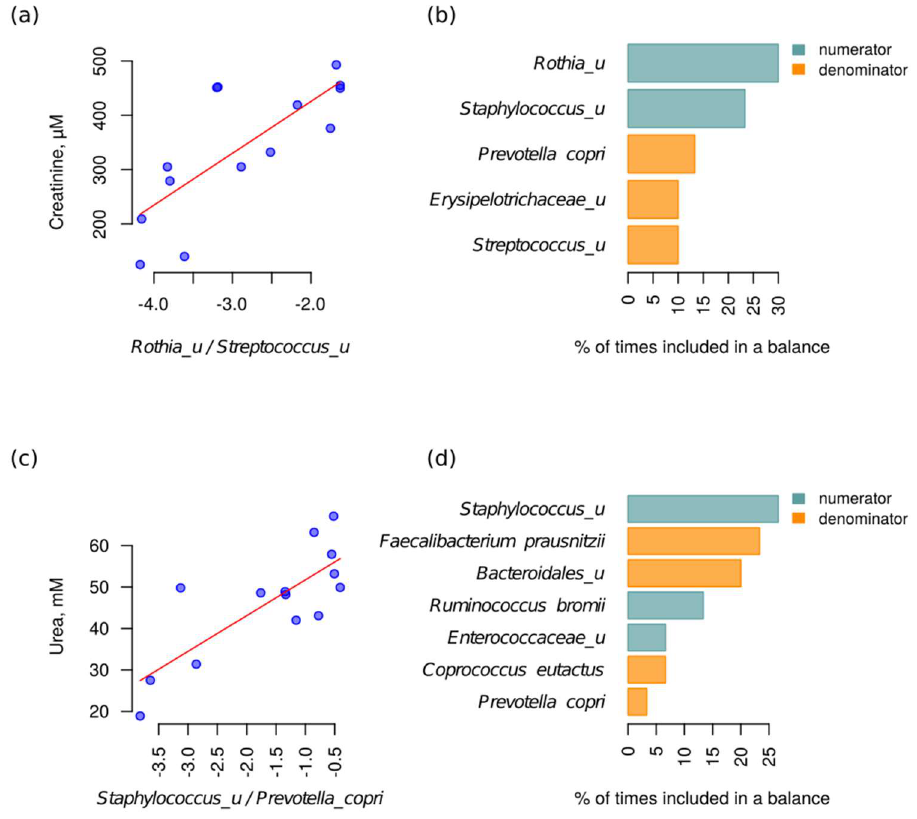
Figure 3. Bacterial balances associated with blood creatinine and urea values. ( a , c ) Linear regression between bacterial balances and metabolite values (a—creatinine, c—urea). The balances that were the best predictors in the analysis of the entire dataset are shown in the figure. ( b , d ) The occurrence of taxa among balance numerators or denominators (b—creatinine, d—urea). The members of 3 balances that were most frequent during the cross-validation procedure are shown. Designation “_u” denotes the unclassified species from the corresponding